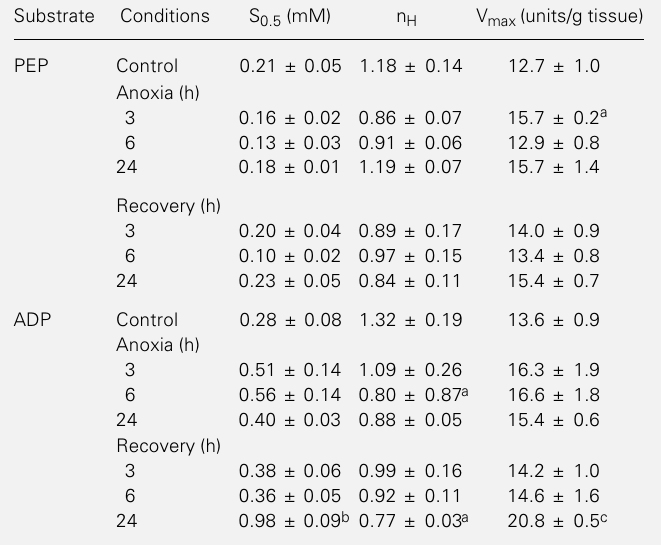
Table 1 - Kinetic properties of pyruvate kinase from mussel foot